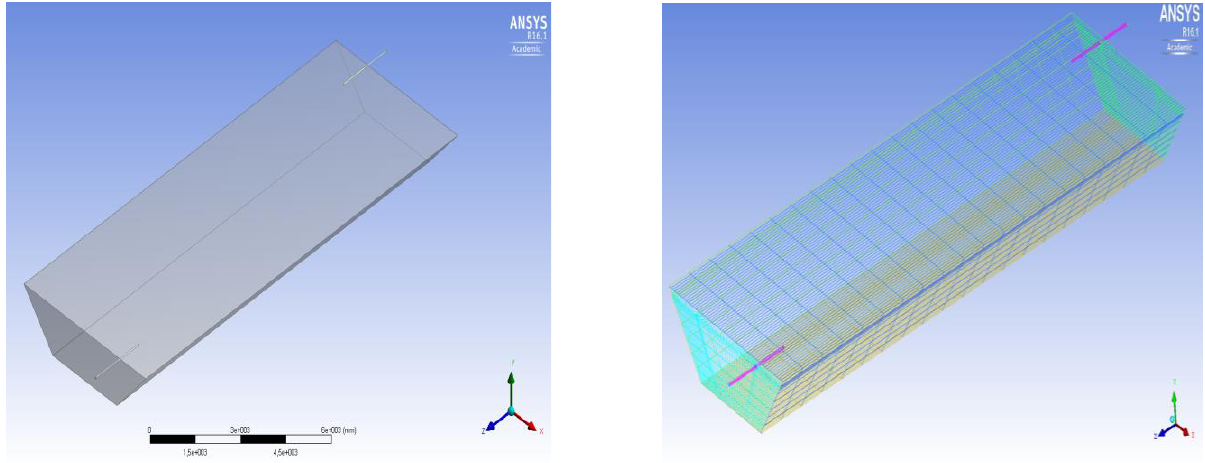
Figure 1. Geometry and mesh used in CFD model.